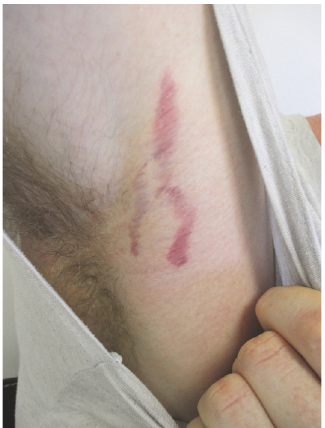
Figure 1: Violaceous, atrophic, linear striae in the right axilla and proximal